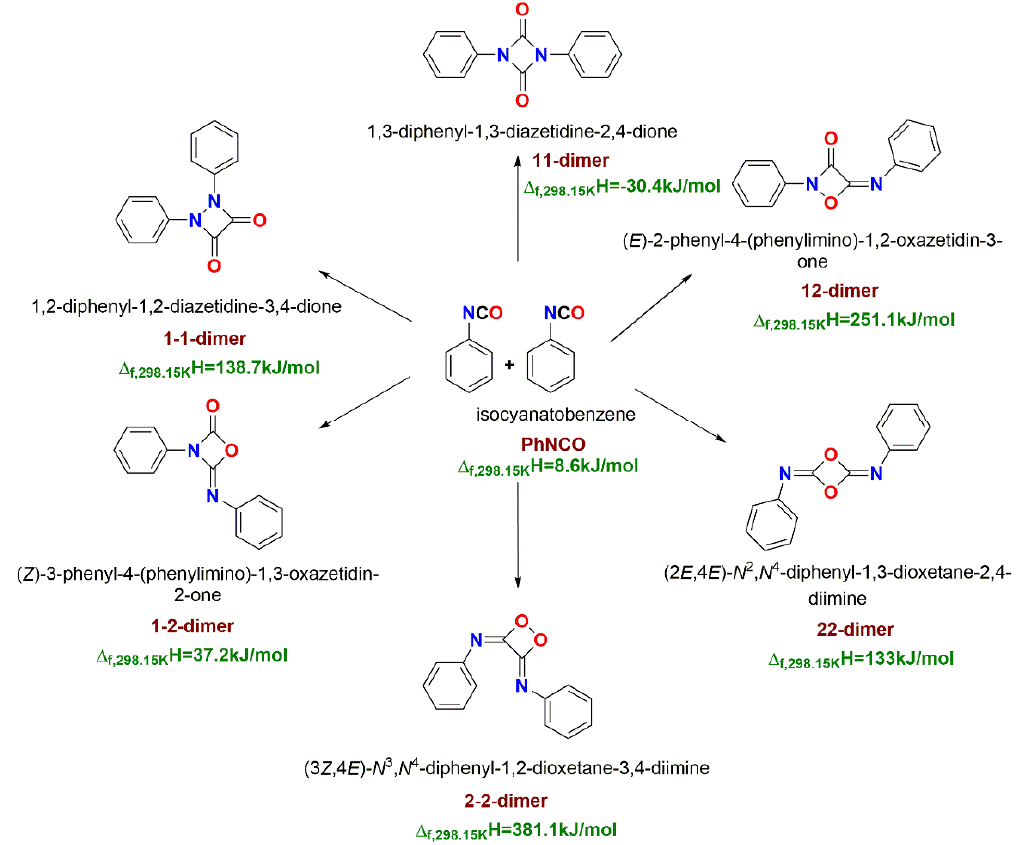
Figure 1. Reaction scheme for the cyclodimerization of phenyl isocyanate. The gas-phase G3MP2B3 standard enthalpy of formation values are also provided (green values). G3MP2B3 thermochemical properties calculated in the gas phase and in